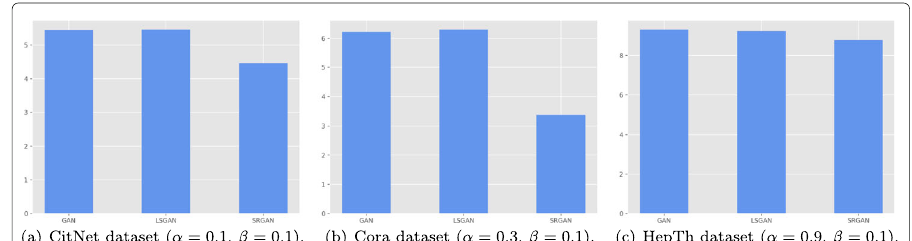
Fig. 4 Results of Q l distance on the three datasets in neighborhood preserving over the DDA methods 2